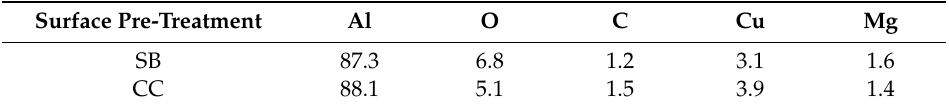
Table 2. Average chemical composition (in wt %) of the SB and CC pre-treated AA2024-T3 surface before aging by EDS analysis.